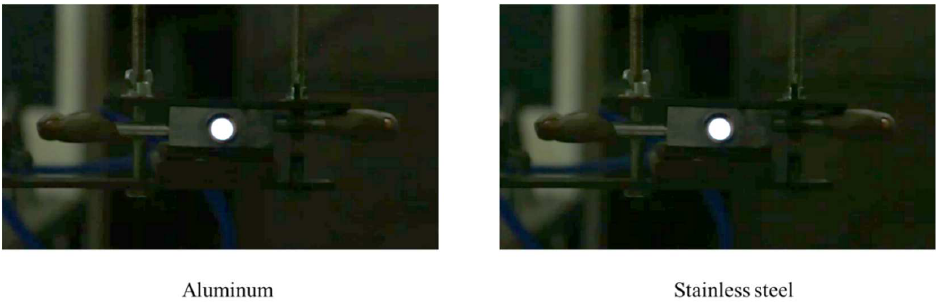
Figure 16. Stable flame appearance in vertical vortex combustors